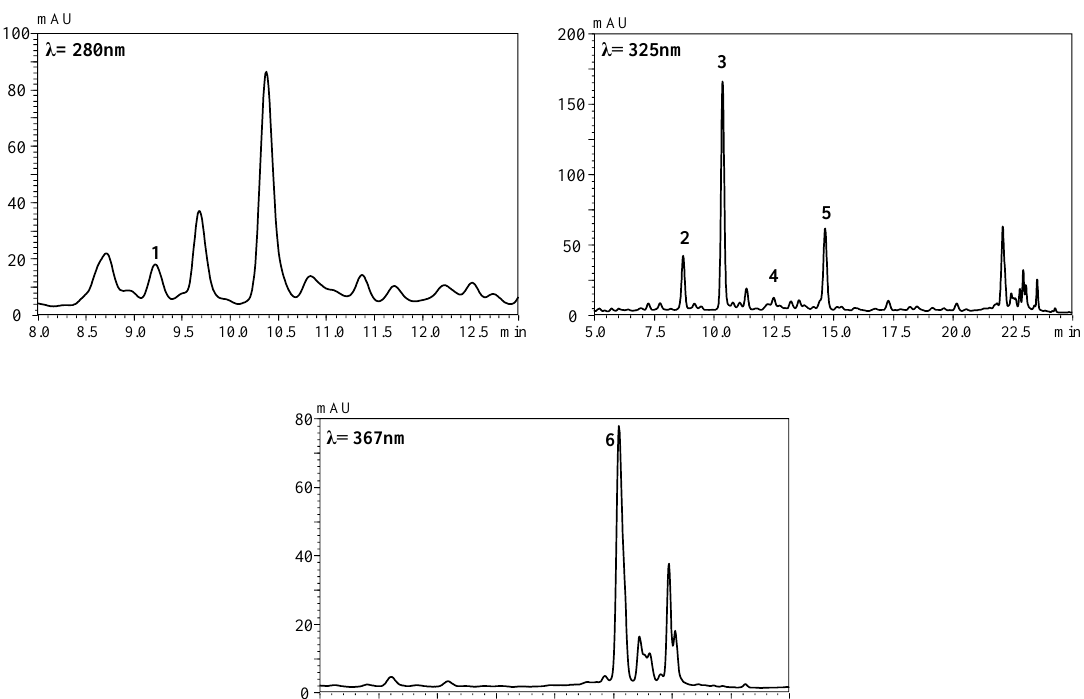
Figure 1. HPLC-DAD chromatograms of the phenolic compounds of the control mixed beverage. The compounds identified were catechin (1), 4-caffeoylquinic acid (2), 5-caffeoylquinic acid (3), p -coumaroylquinic acid isomer 1 (4), p -coumaroylquinic acid isomer 2 (5), and quercetin-3- O -glucoside (6).